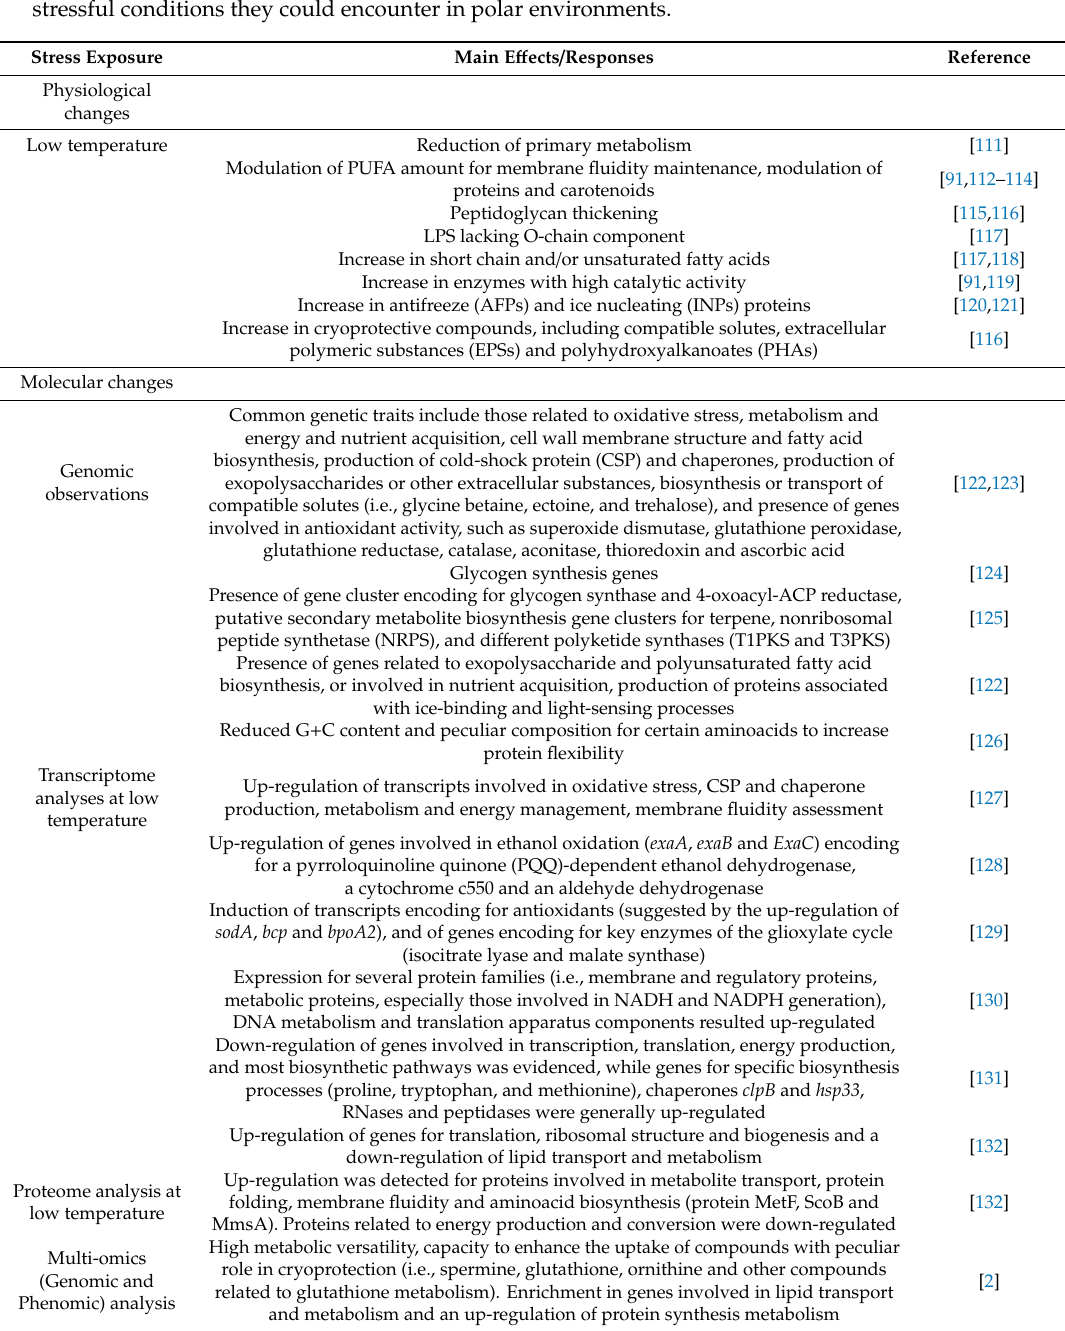
Table 2. Main physiological and molecular e ff ects / responses observed for bacteria exposed to the stressful conditions they could encounter in polar